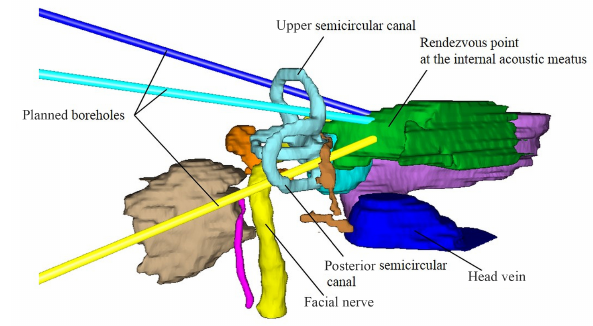
Figure 3. Three planned boreholes. The planned target point is the internal auditory canal (based on Pollmanns, 2014).